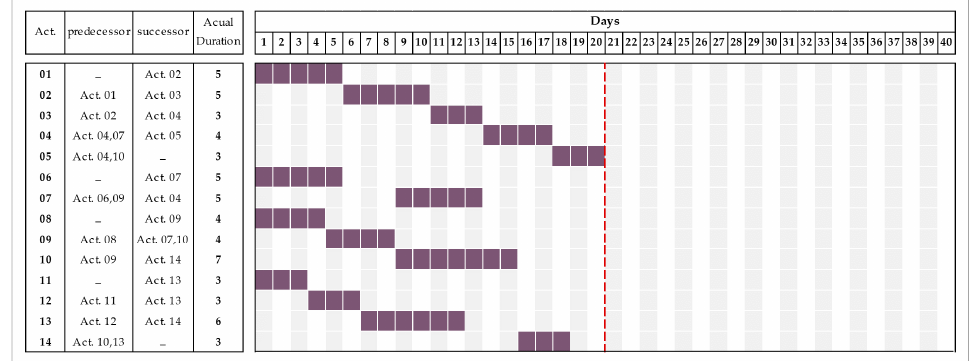
Figure 3. As-planned schedule.